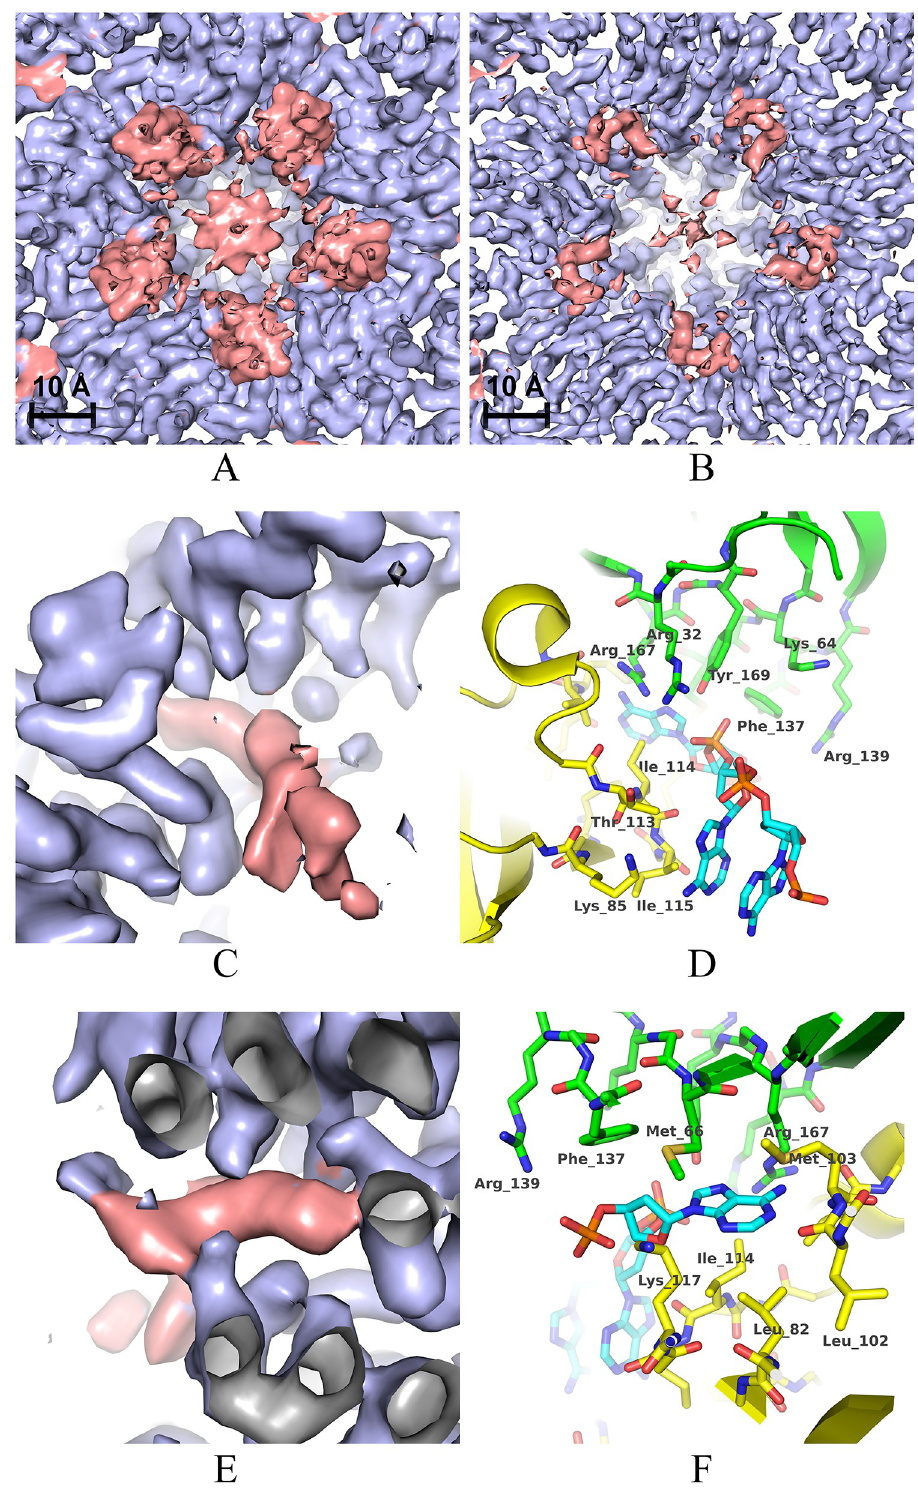
Fig 5. Residual genomic density in proximity of the fivefold CP-CP interfaces. (A) and (B): unsharpened and sharpened map respectively, viewed from the capsid interior along a fivefold symmetry axis. Density ascribed to the protein shell is coloured in light blue and the residual density ascribed to DNA is coloured in salmon. (C) and (E): two views of a detail of the DNA density showing a putative aromatic base sticking into a fivefold CP-CP interface. (D)